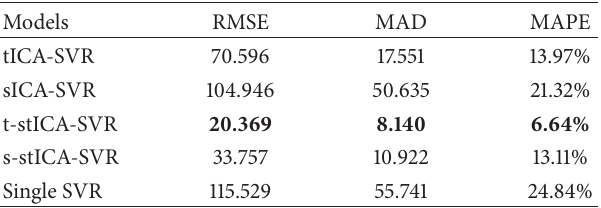
Table 6: Forecasting results of Branch 1 using the five forecasting